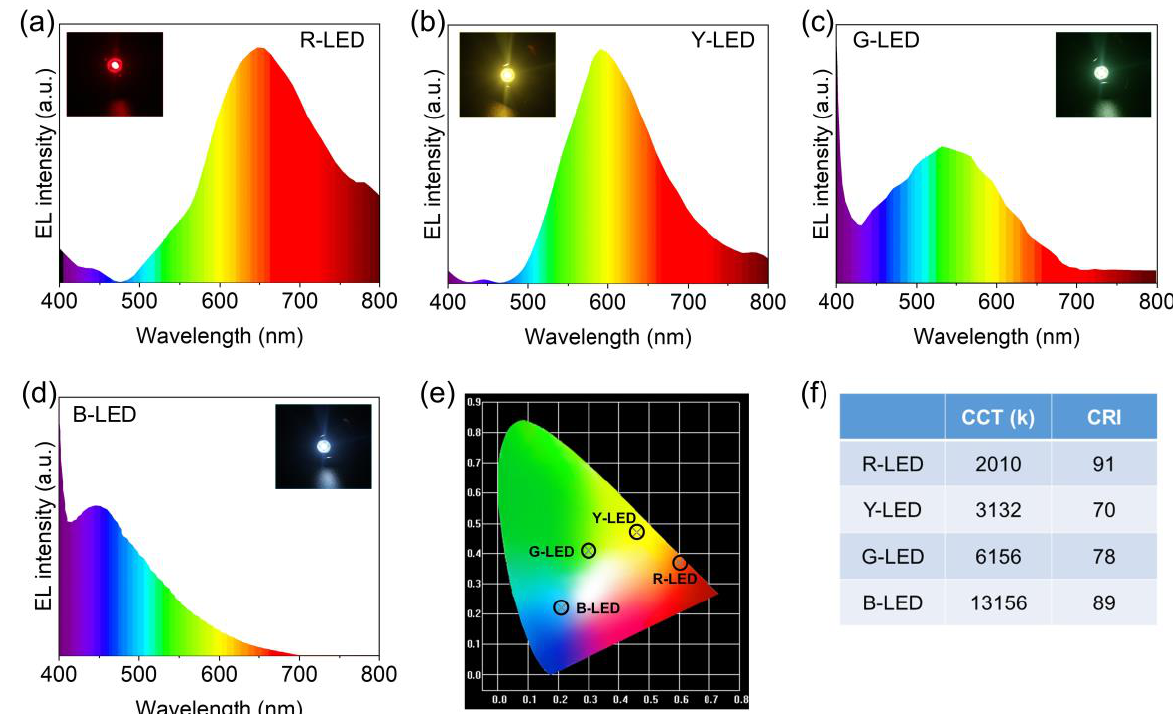
Figure 10. The electroluminescence (EL) patterns of the CD-based LEDs device are: ( a ) R-CD-based LED (R-LED), ( b ) Y-CD-based LED (Y-LED), ( c ) G-CD-based LED (G-LED), and ( d ) B-CD-based LED (B-LED). ( e ) CIE chromaticity coordinates of the R-LED, Y-LED, G-LED, and B-LED. ( f ) Performance of the R-LED, Y-LED, G-LED, and B-LED.